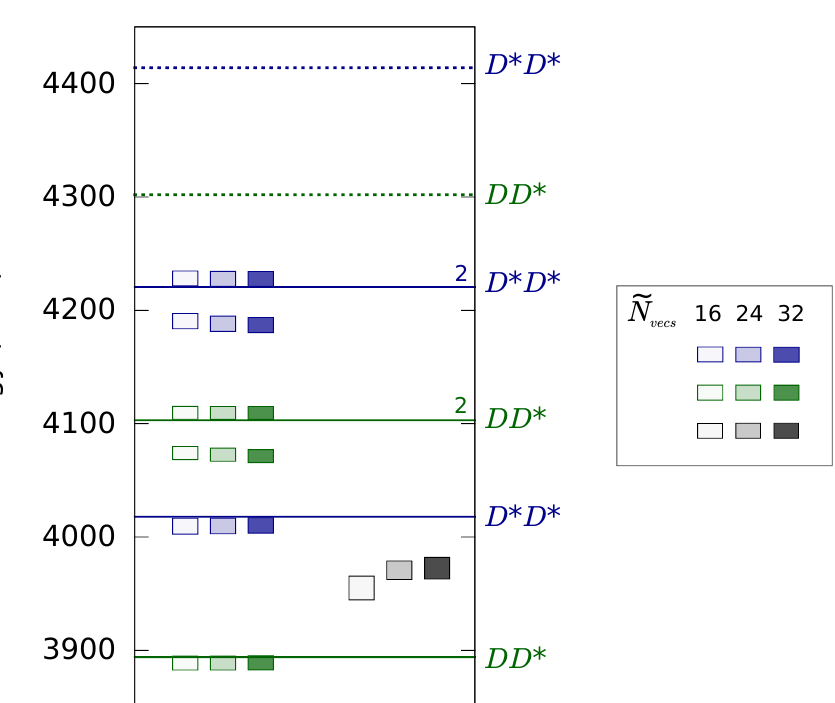
Figure 9 . As (cid:12)gure 6 but showing the (cid:3) P = T + isospin-0 cc (cid:22) l (cid:22) l spectrum calculated using tetraquark 1 operators with di(cid:11)erent numbers of distillation vectors, ~ N vecs = 16 ; 24 ; 32. The left three columns are using the full basis of meson-meson and tetraquark operators, and the right three columns are using only tetraquark